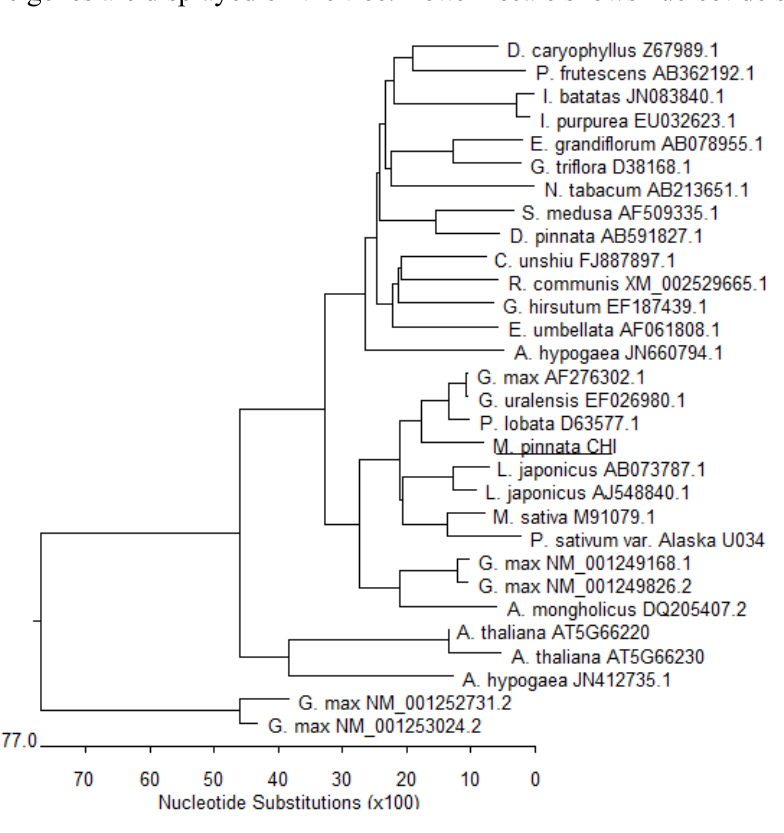
Figure 3. Phylogeny of plant chalcone isomerase ( CHI ) genes, based on 27 different plant CHI and M. pinnata CHI ( MpCHI , underlined) nucleotide sequences cloned in this study, indicating MpCHI is a close relative of leguminous CHIs, with two soy bean actin cDNAs as control (Bottom G. max NM_001252731.2 and G. max NM_001253024.2). The accession numbers for the genes are displayed on the tree. Bottom scale shows nucleotide substitutions.